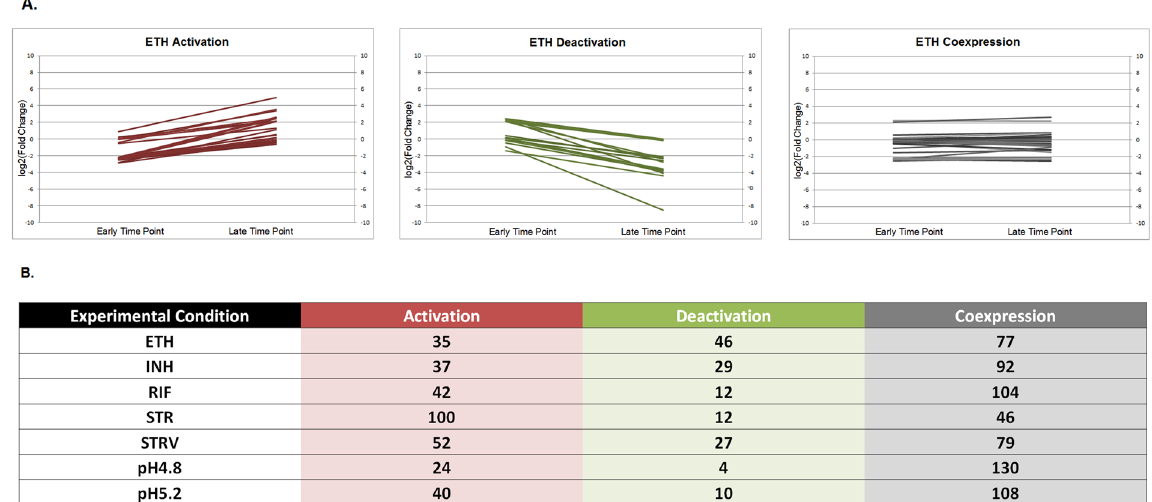
Figure 5. ( A ) Line Graph depicting the approach used to calculate activation and deactivation scores for TA loci ( B ) Number of TA loci that are activated, deactivated and co-expressed in each of the experimental conditions profiled. Fold change of toxin from cognate antitoxin was subtracted in early and late time point. The subtracted scores were subjected to biclustering/K-means clustering using Pearson Uncentered algorithm in GeneSpring Gx v 12.8 to provide 3 clusters of all the 78 TA loci, with clusters representing activation, deactivation and co-expression status. Similar approach was followed for each of the experimental conditions and TA loci activated, deactivated and co-expressed in each condition were